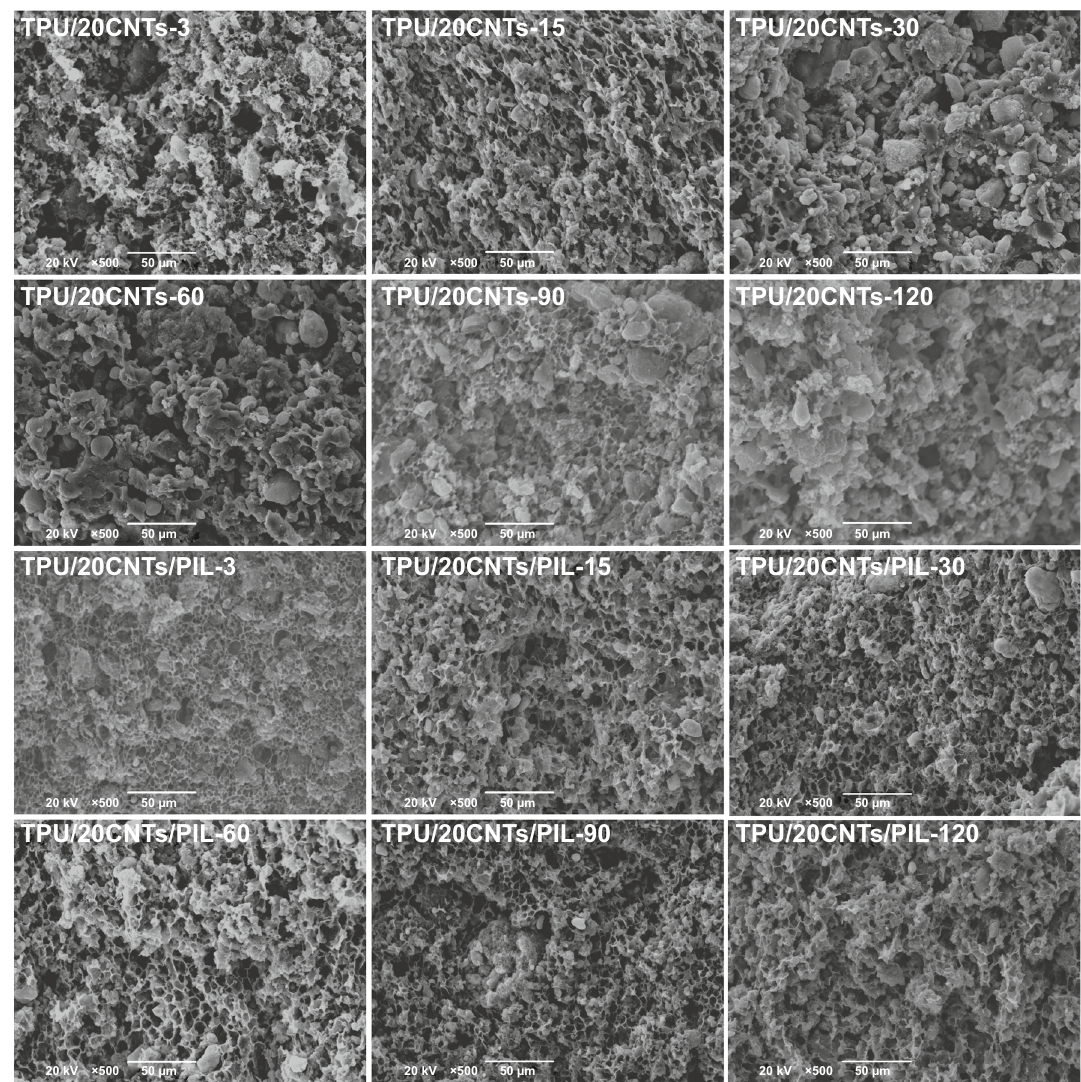
Fig. 4 SEM images of TPU/20CNTs and TPU/20CNTs/PIL composite foams with different evaporate time (3, 15, 30, 60, 90 and 120